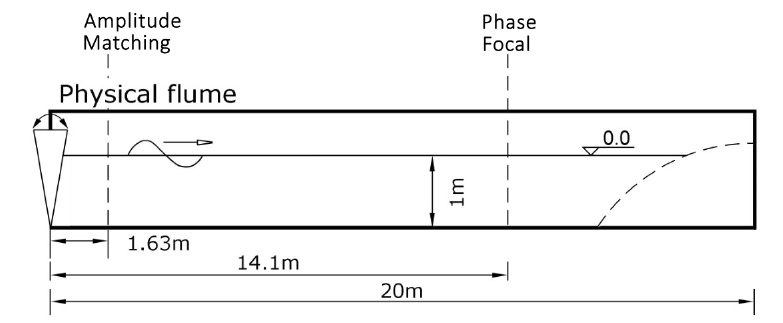
Figure 1. Schematic of the physical wave flume at